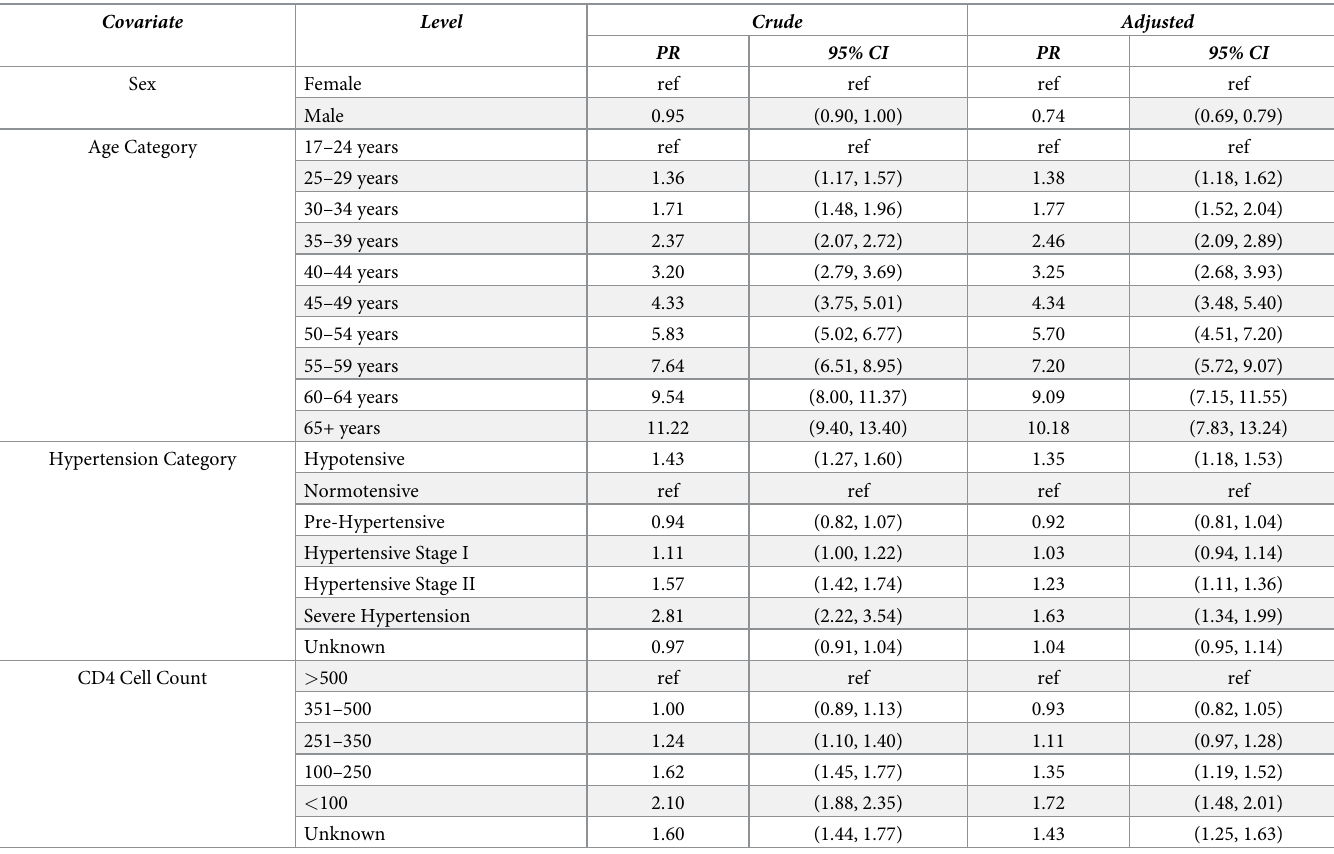
Table 2. Crude and adjusted prevalence ratios for eGFR (CKD-EPI) < 60ml/min/1.73m 2 at baseline. Covariate